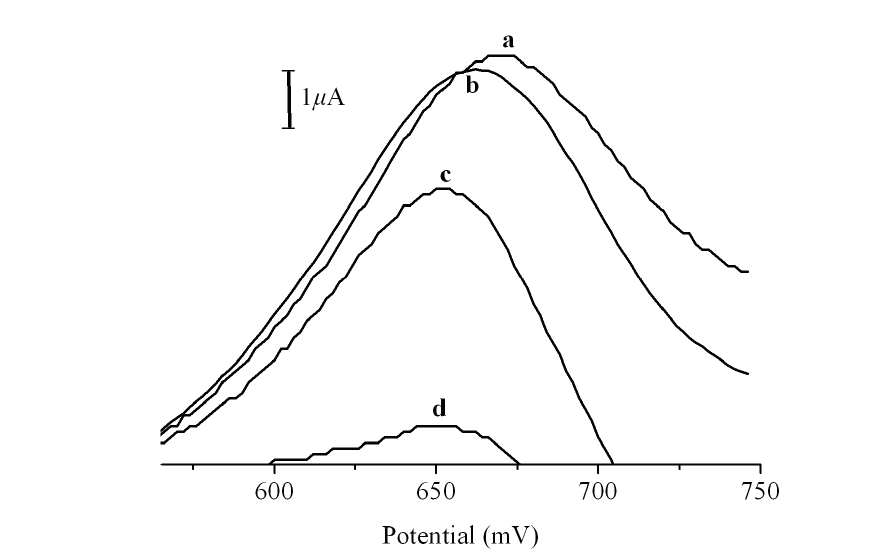
Figure 3. Square wave voltammograms of 5.1×10 -5 M hIAPP incubated at 37 o C for (a) 0